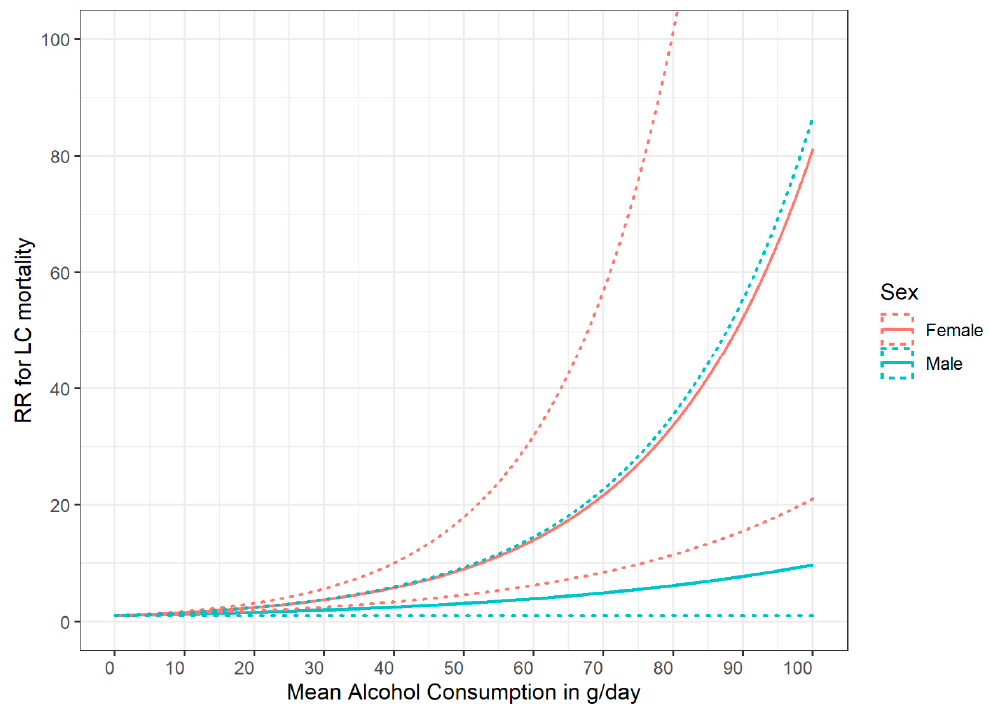
Figure 1. Relative risk for liver cirrhosis mortality as a function of mean alcohol consumption (based on [43]). RR: Relative Risk; LC: liver cirrhosis; solid lines denote point estimates, dashed lines the 95% confidence intervals